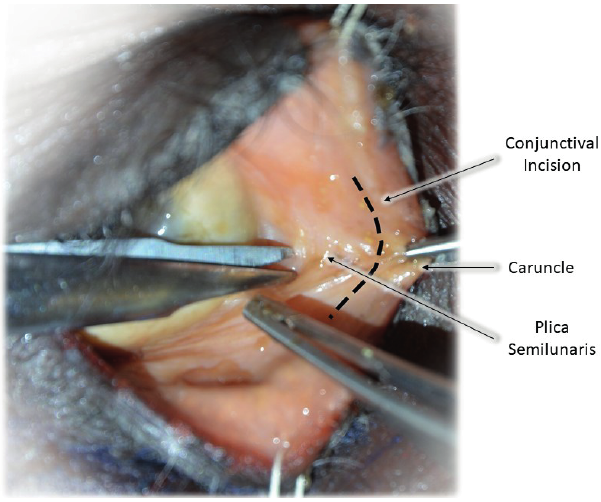
Figure 2. Relationship of conjunctival incision to caruncle (cadaver).